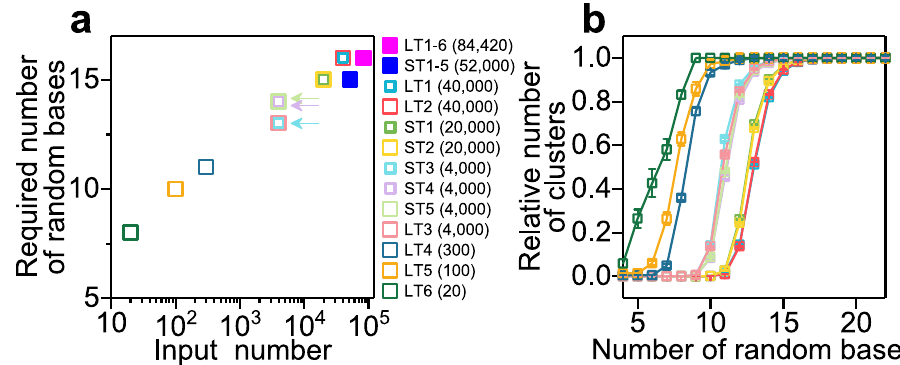
Figure 5. Required number of random bases for digital counting. ( a ) The x-axis indicates the input number of molecules to be measured, and the y-axis represents the number of random bases at which each curve in Figs 4b and 5b reached a relative number of clusters of 0.95. Colors correspond to the samples represented by the plots in Figs 4b and 5b. ( b ) Dependency of the relative number of barcode clusters on the number of random bases. All templates with index A and index B after clustering ( Distance = 2), fixed base match filtering ( Fixed base number = 4), 10% of total reads sampled randomly (e.g., coverage is 12.6–20.9). Colors correspond to the samples represented by the plots in Fig. 4a. Error bars represent standard deviation (n =